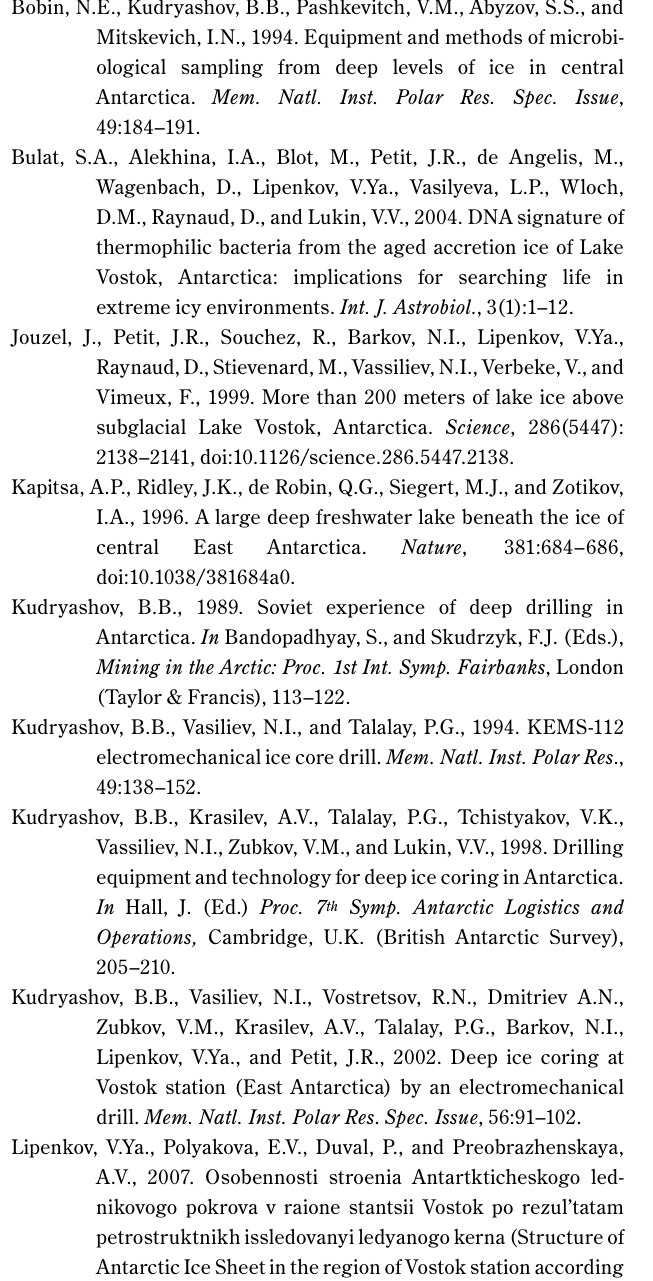
All photos were provided by members of Vostok drilling